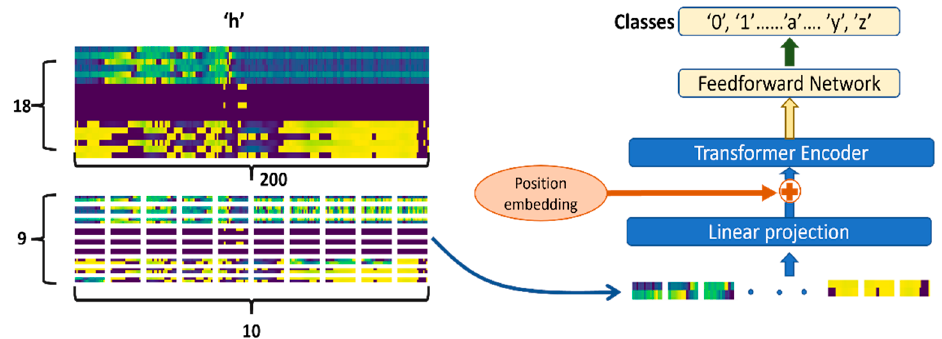
Figure 8. The structure of the transformer network, ViT.